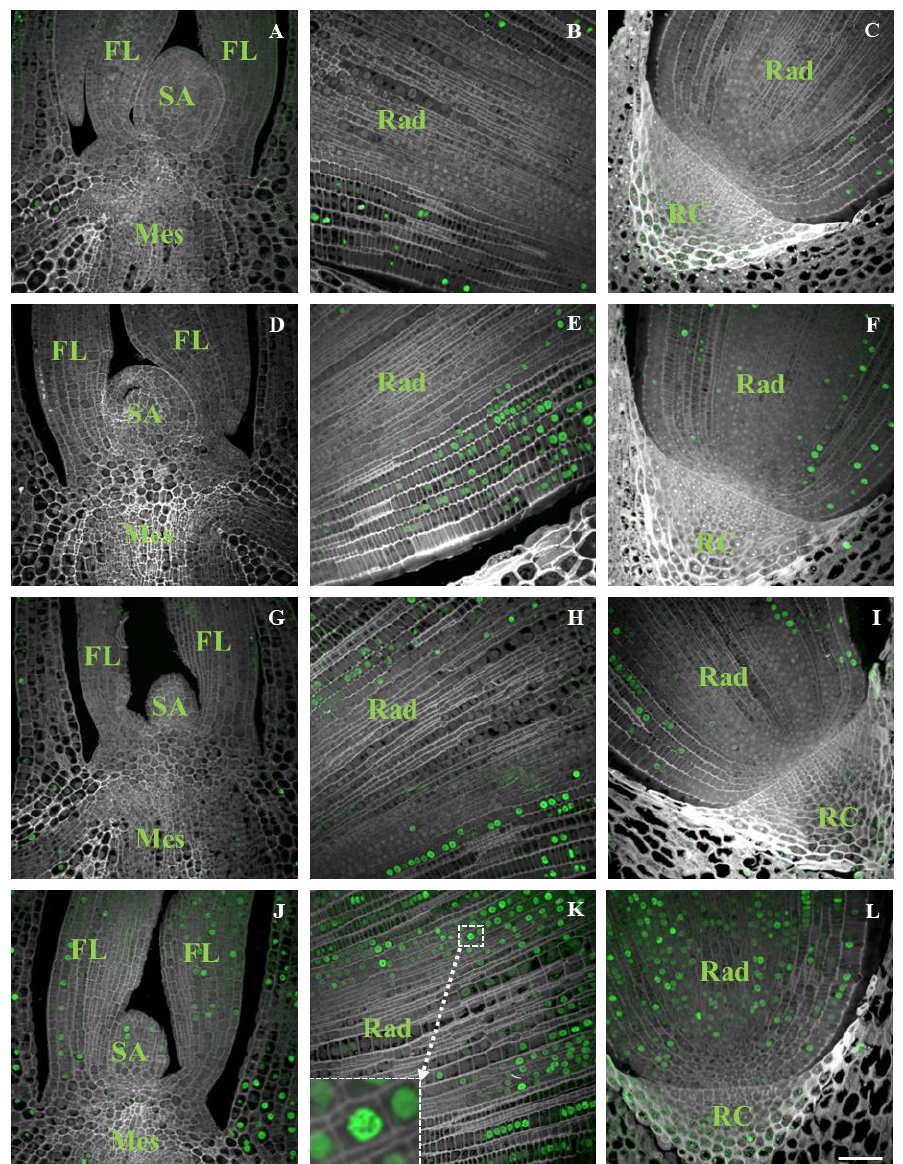
Figure 4. Detection of EdU (green fluorescence) incorporated into actively replicating nuclei in Brachypodium embryos during imbibition. Fragments of cross sections through embryos 11 HAI ( A – C ), 12 HAI ( D – F ), 13 HAI ( G – I ), and 14 HAI ( J – L ). Cross sections through the shoot apex ( A , D , G , J ), radicle ( B , E , H , K ), and radicle with a visible root cap ( C , F , I , L ). Inset in ( K ) presents an enlargement with the nucleus at prophase. Abbreviations: SA—shoot apex, FL—first leaf, Mes—mesocotyl, Rad—radicle, RC—root cap. The slides were counterstained with DAPI (grey fluorescence). The grey colour of cell walls was caused by their autofluorescence. Scale bar represents 20 µ m; all photomicrographs were taken at the same